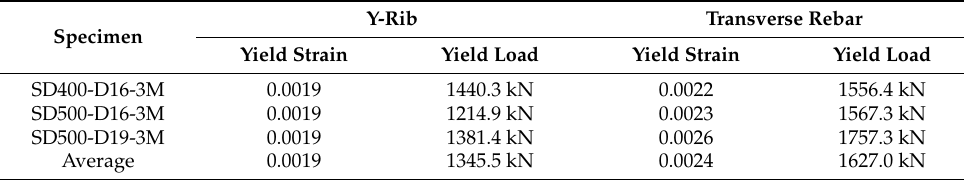
Table 6. Yield strength corresponding to the yield strains for each